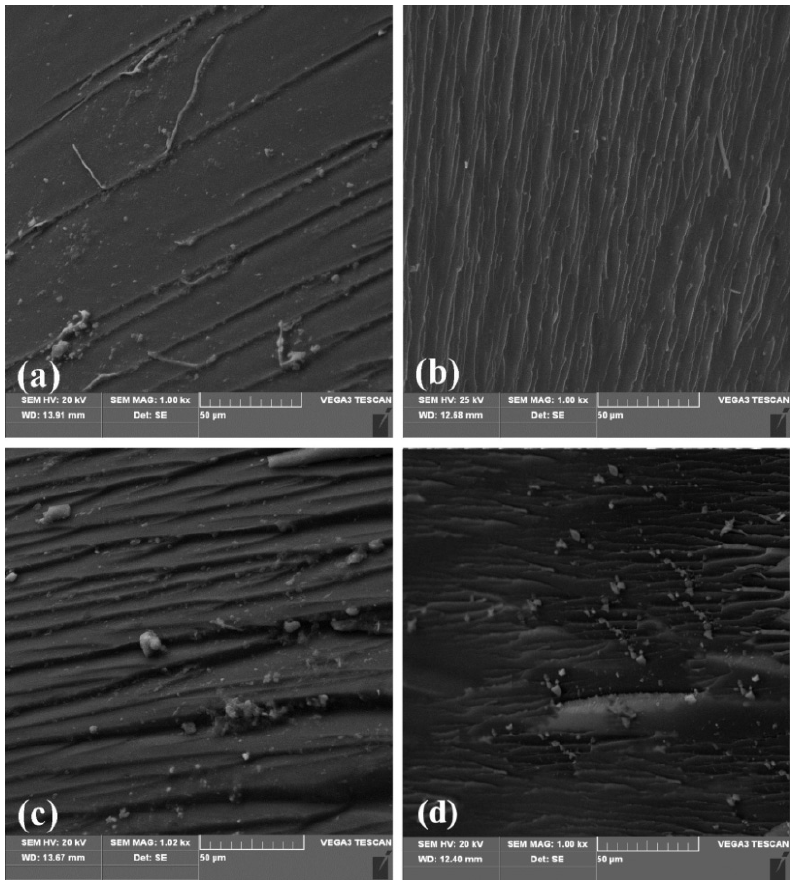
Figure 6. Effect of ES-GO content on the morphology of fractured surface of BMI with ES-GO contents: ( a ) 0, ( b ) 0.1 wt.%, ( c ) 0.3 wt.%, ( d ) 0.5